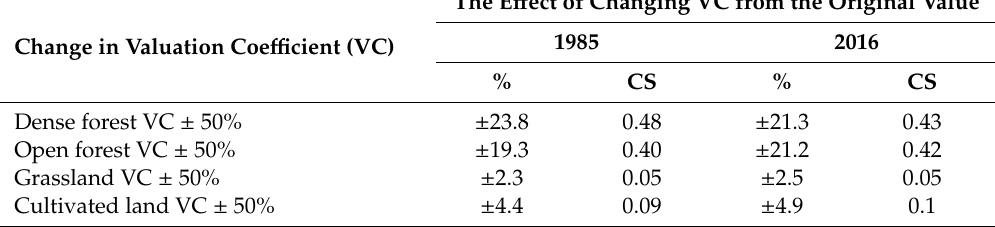
The E ff ect of Changing VC from the Original Value 1985